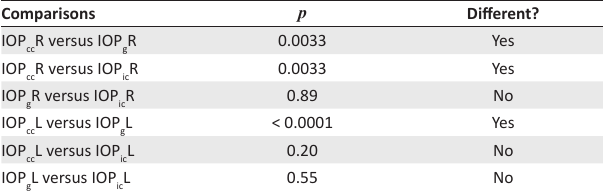
TABLE 3: Mean differences between IOP measures, 95 % confidence intervals on the mean difference, and the upper and lower limits for all measurements.